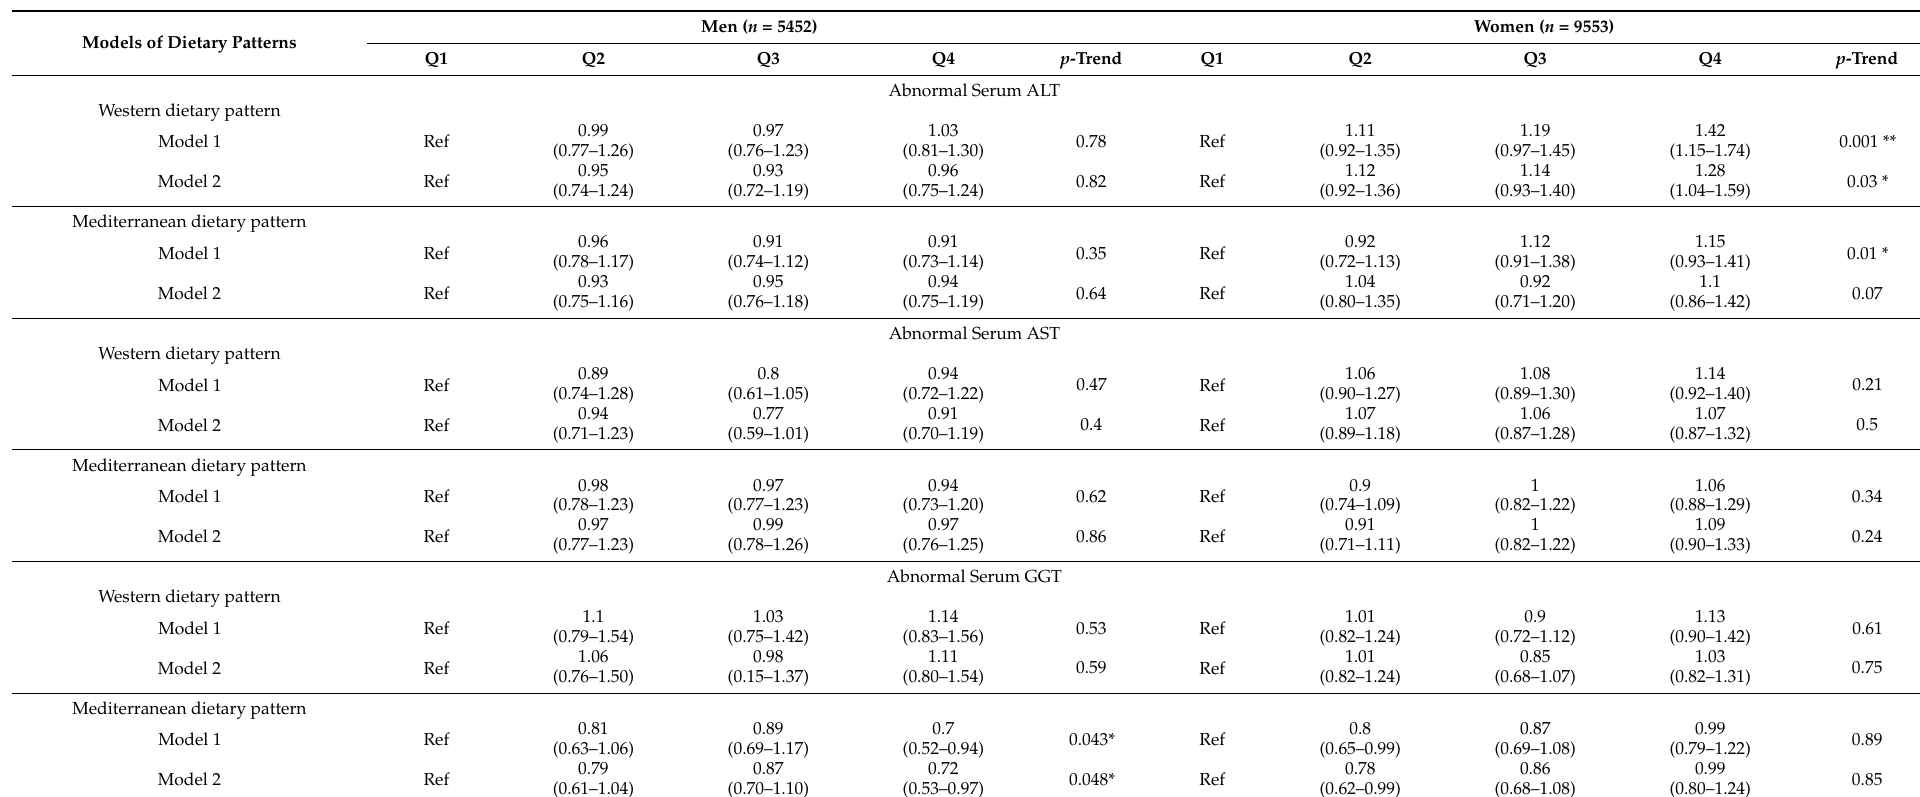
Table 7. Odds ratios for abnormal serum hepatic enzyme levels across quartiles of major dietary patterns stratified by gender ( n = 15,005) 1 . Models of Dietary